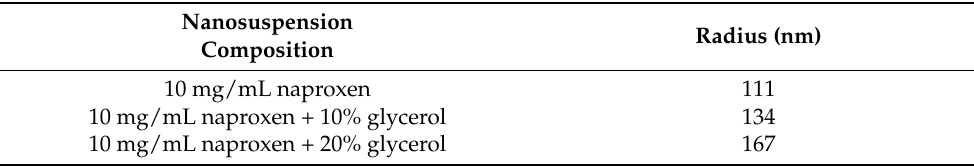
Table 2. Effect of addition of glycerol as a viscosity enhancer on the particle size of naproxen nanosuspensions